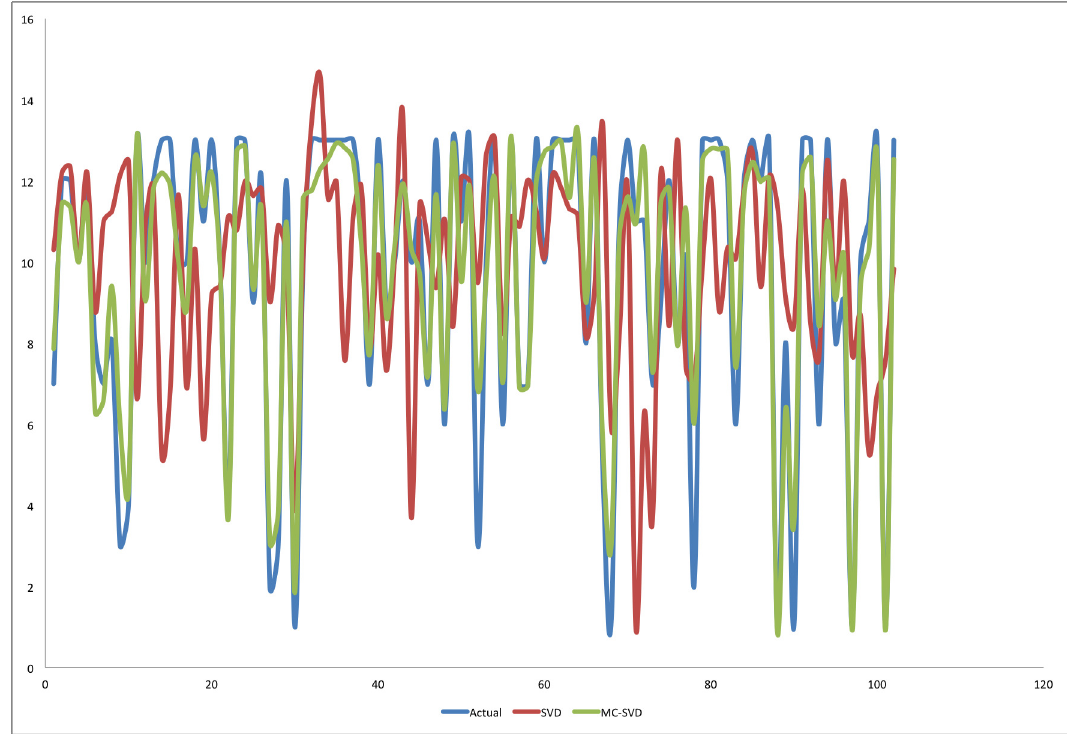
Figure 4. Graph of Actual vs. MC - SVD and SVD predicted